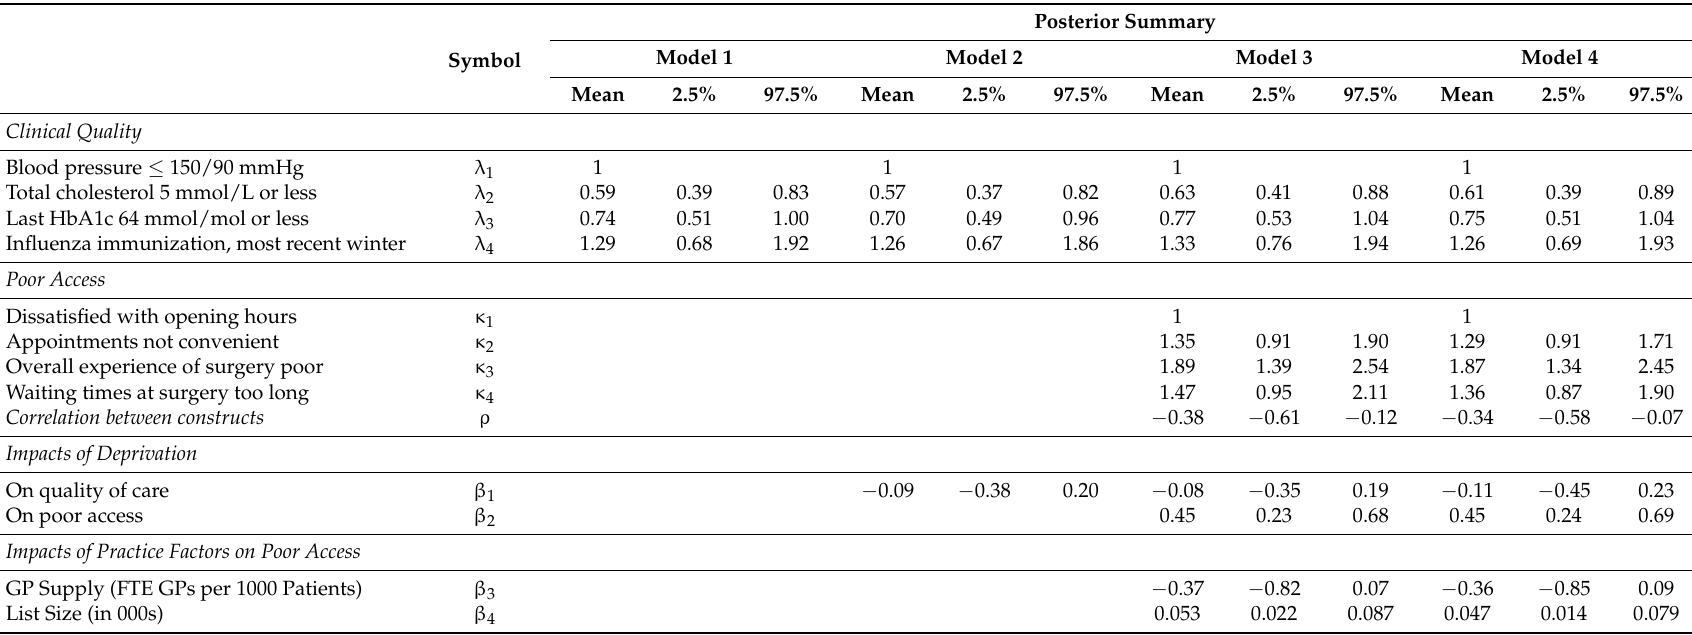
Table 4. Measurement model